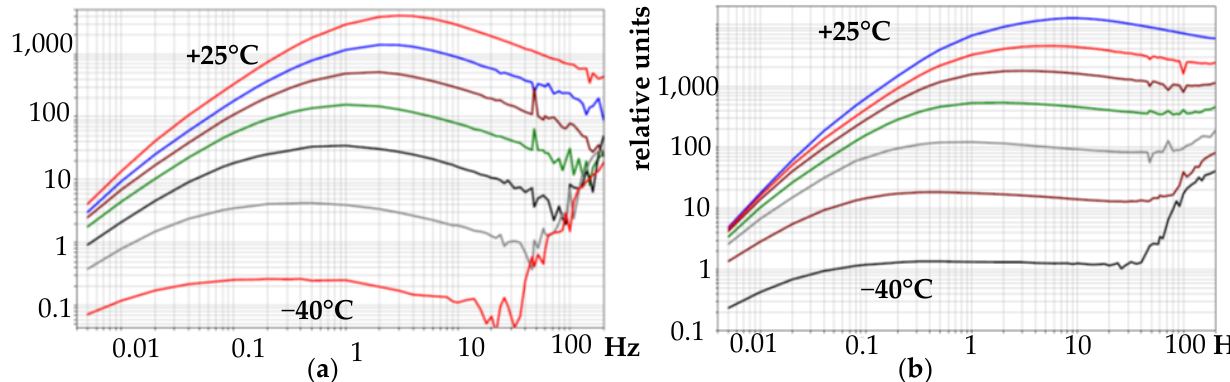
Figure 4. Families of amplitude-frequency characteristics of the studied samples depending on the ambient temperature (+25, +10, 0, −10, −20, −30, −40 °С ), along the abscissa axis there is Frequency in Hz, relative units along the ordinate axis proportional to V/m/sec: ( a ) For the electrolyte sample #3 PC/LiI; ( b ) For the electrolyte sample #4 Water/KI/PC, J 2 = 0.01 mol/liter.